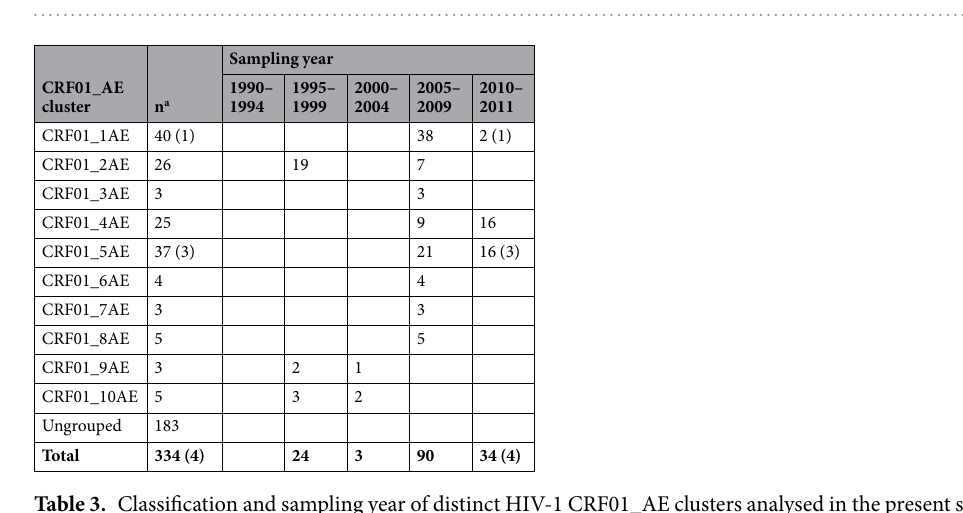
Table 2. Classification and risk factor of distinct HIV-1 CRF01_AE clusters analysed in the present study. a Numbers of HIV-1 CRF01_AE sequences newly reported in our study are shown in parentheses. b Risk group: Hetero, heterosexual; IDU, injecting drug user; MSM, men who have sex with men; MTCT, mother-to-child transmission; ST, sexual transmission, unspecified type; n/a, not available.